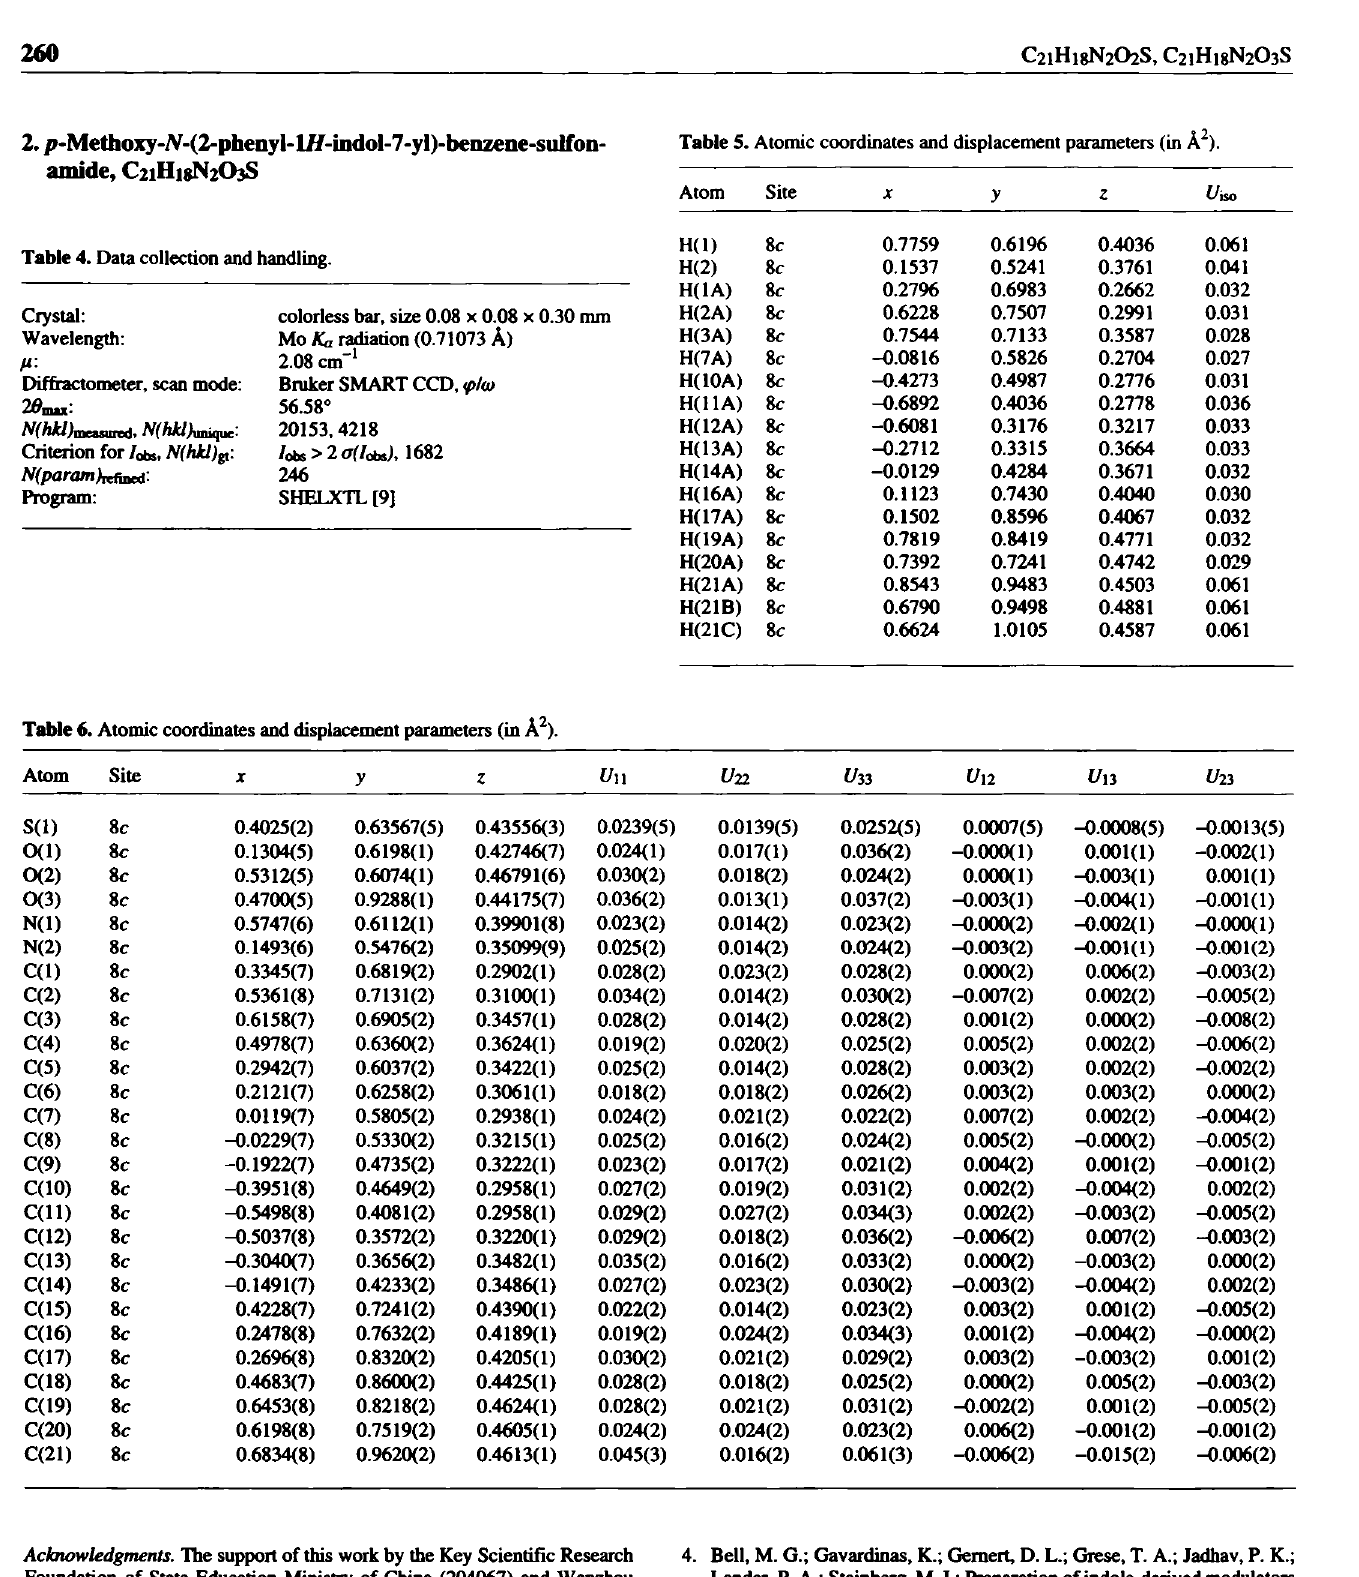
Table 5. Atomic coordinates and displacement parameters (in A 2 ).